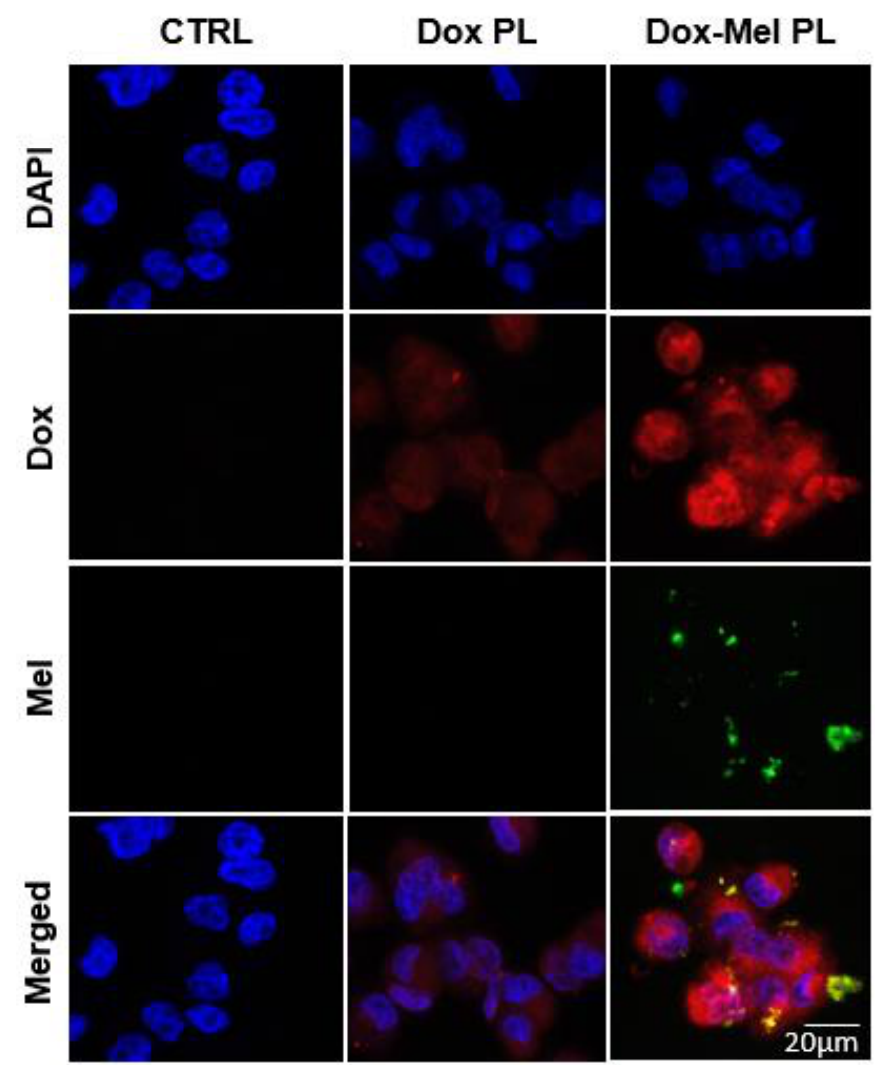
Figure 3. Confocal microscopy images showing the intracellular distribution of doxorubicin and melittin in MCF-7/ADR cells. Cell nuclei are shown in blue. Doxorubicin and melittin are represented by red and green channels, respectively. (Scale bar = 20 μm) .